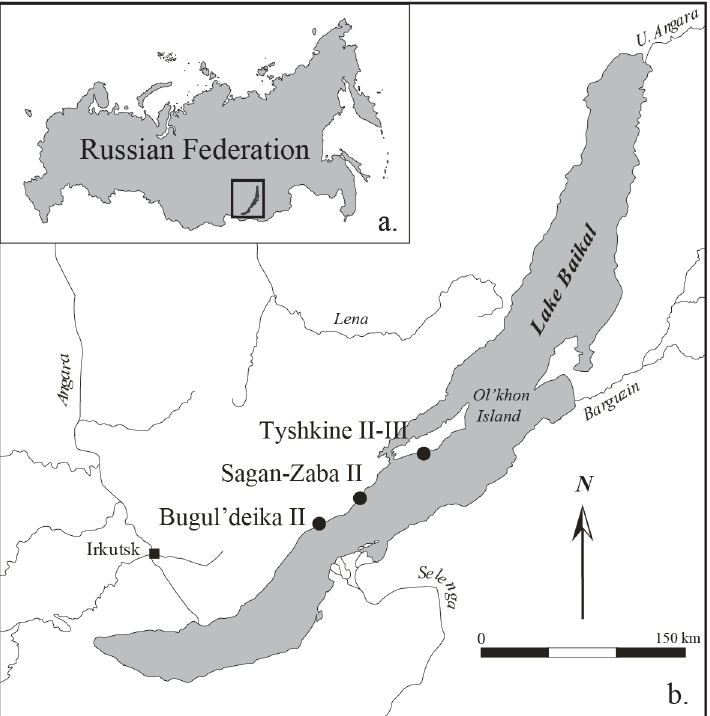
Fig 1. Study area: a. Lake Baikal, Russian Federation; b. archaeological sites mentioned in the text.